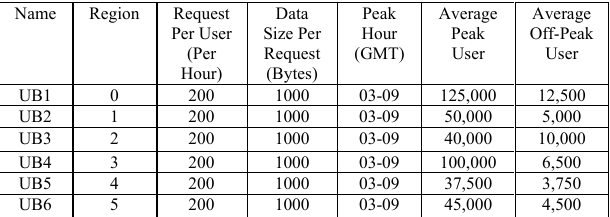
Table 3. Experiment 1 User Base configuration